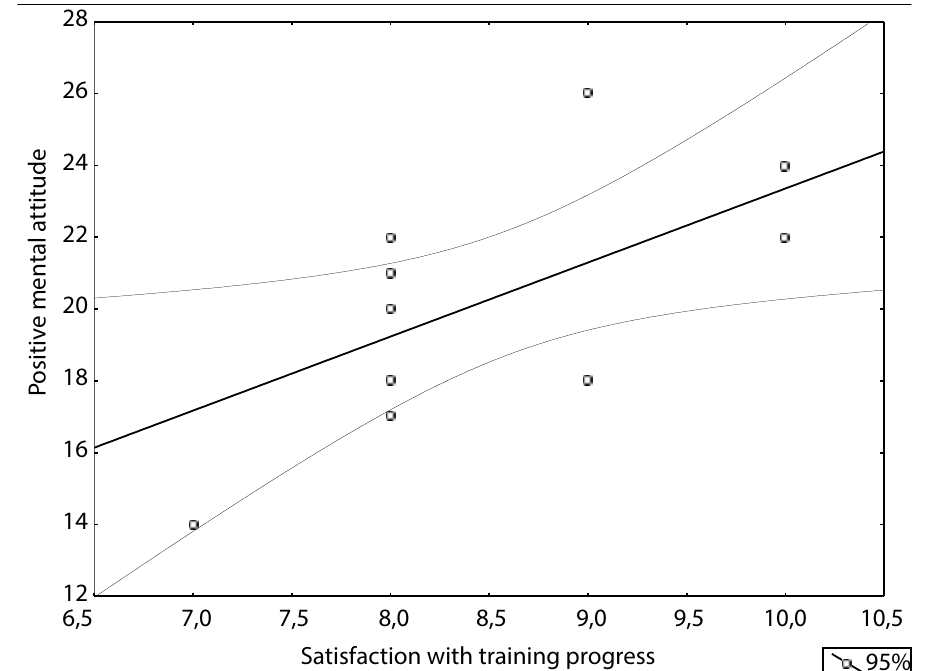
Figure 2. Relationship between positive mental attitude and the satisfaction with training progress ( r= 0.62;